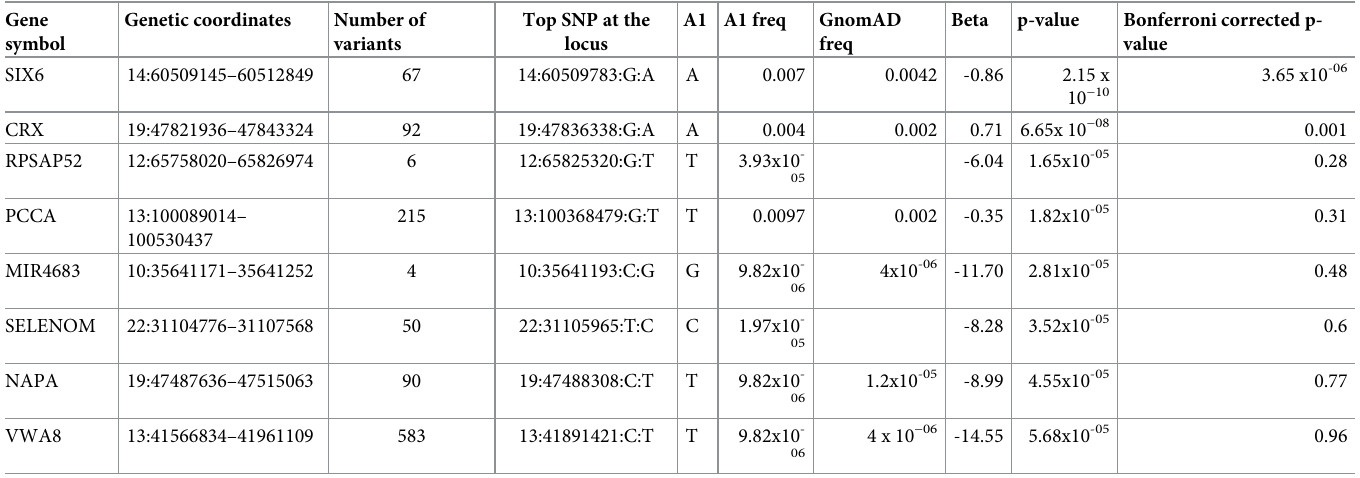
Table 2. Top eight gene associations with refractive error. Gene Genetic symbol